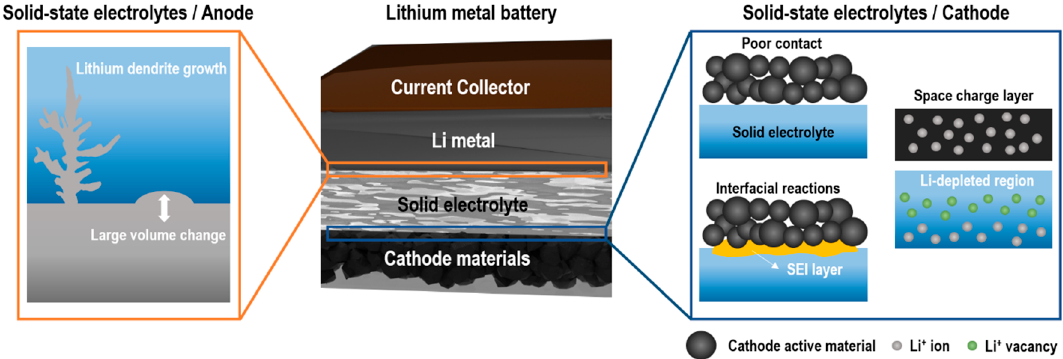
/ electrolyte interface